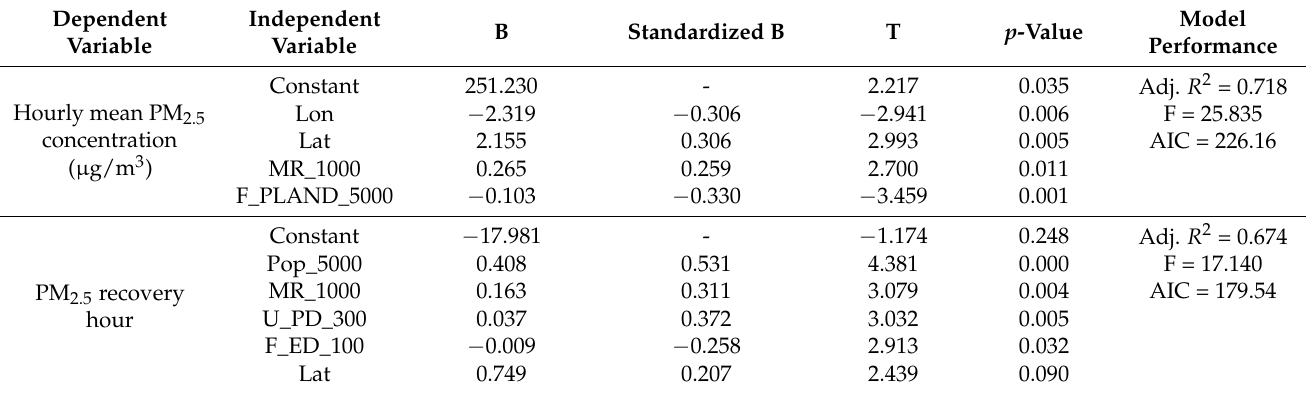
Table 2. Results of the OLS models based on AIC stepwise model